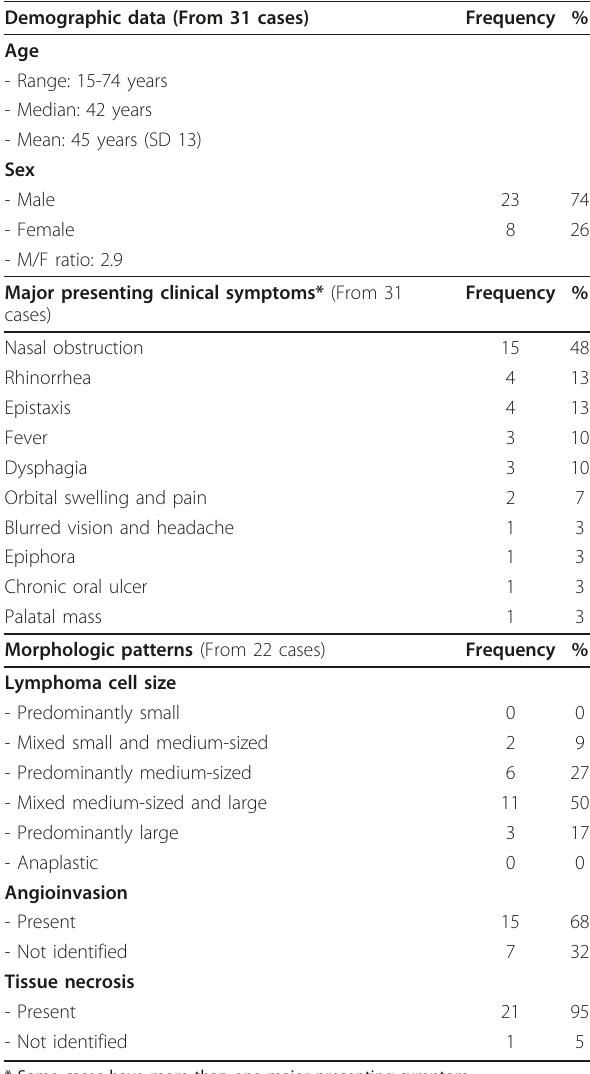
Table 3 Summary of basic clinico-pathological features of extranodal NK/T-cell lymphoma, nasal type of head and neck